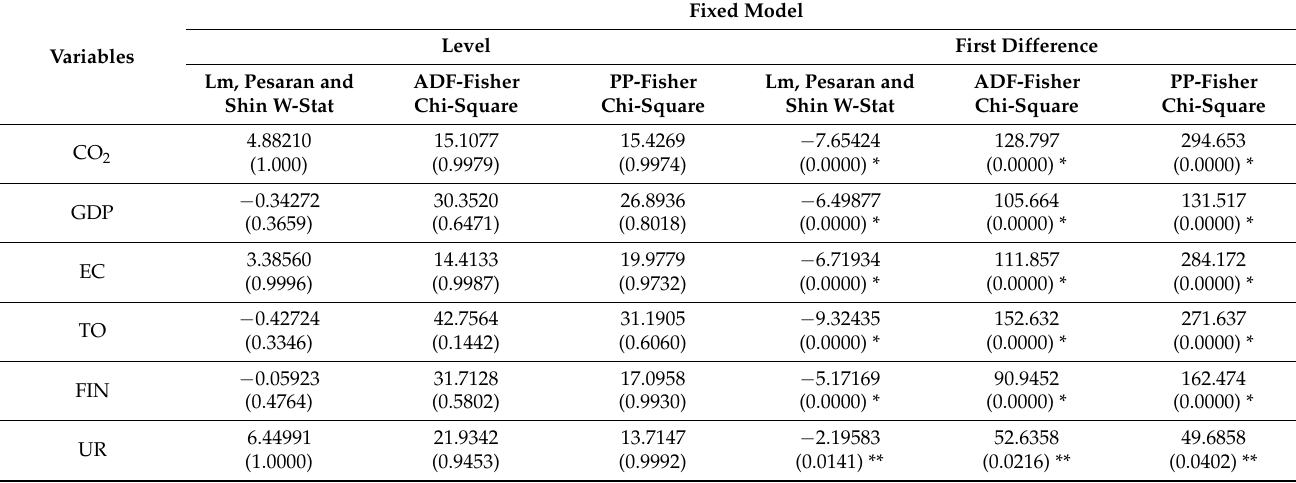
Table 4. Panel unit root